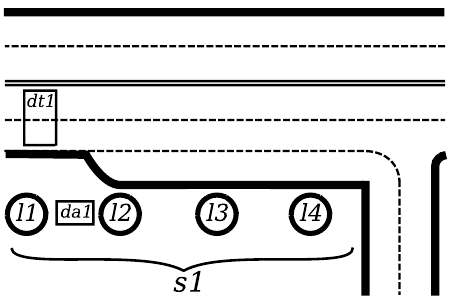
Figure 1. A street segment s 1, with luminaires l 1, . . . , l 4, a traffic intensity detector dt 1 and an ambient light detector da 1.